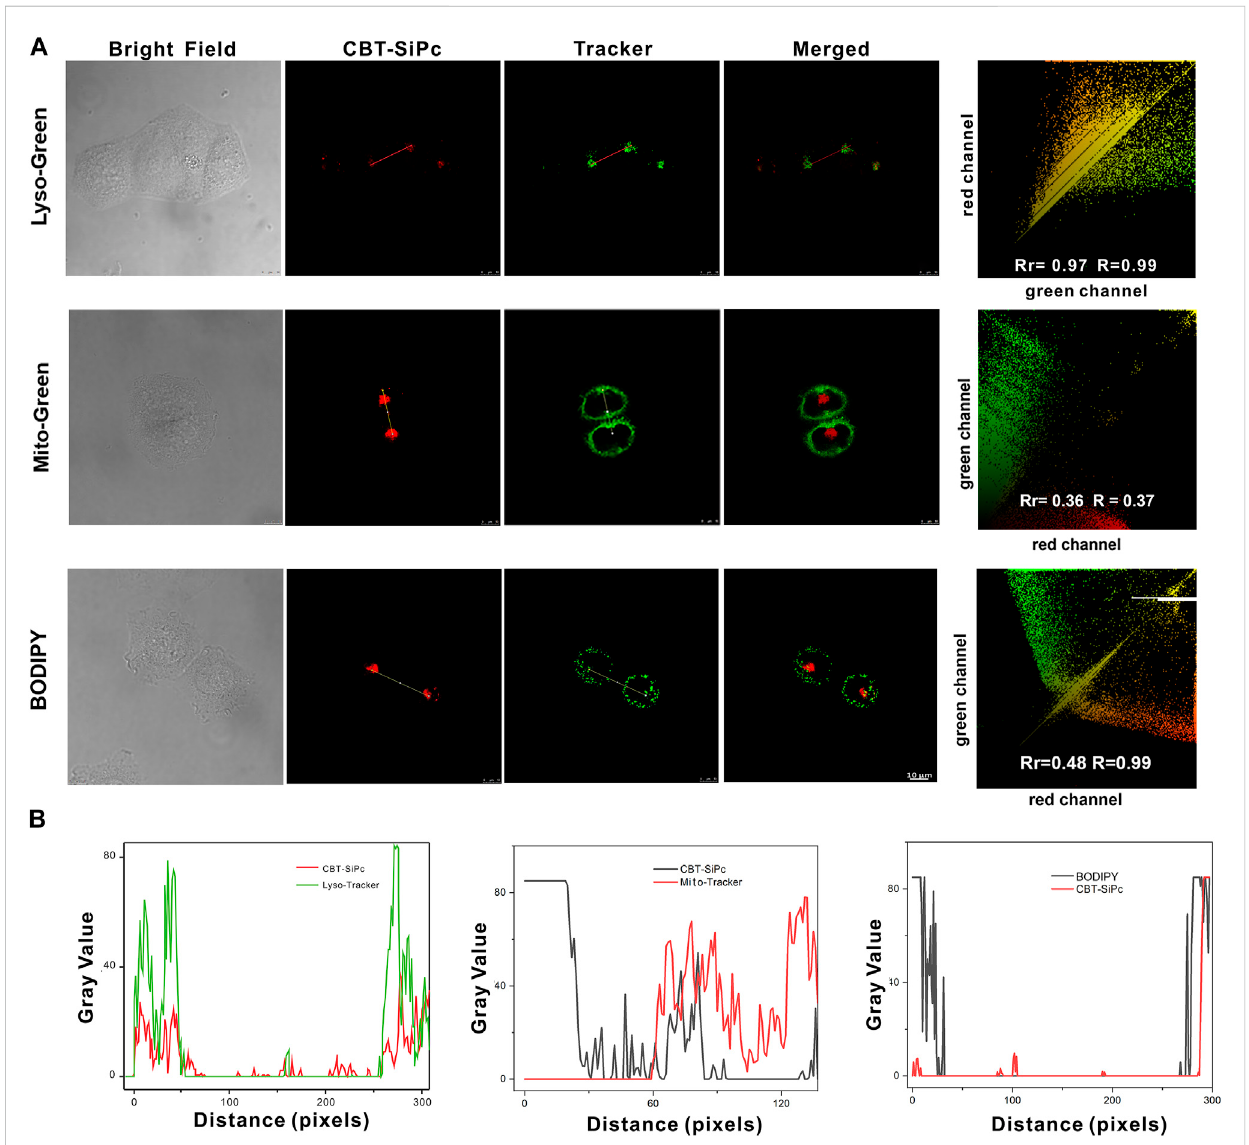
FIGURE 3 SubcellularlocalizationofCBT-SiPcinMCF-7breastcancercells. (A) IntracellulardistributionofCBT-SiPcinMCF-7cells.Lysosomes,mitochondria, and lipid droplets were stained with commercial LysoTracker (Lyso-Green), MitoTracker (Mito-Green), LipidTracker (BODIPY), and merged images observed by CLSM; (B) co-localization curves of CBT-SiPc with LysoTracker (Lyso-Green), MitoTracker (Mito-Green), and LipidTracker (BODIPY) (CBT- SiPc, excited by 860 nm fs laser). The fl uorescence was monitored at 650 – 750 nm. Lyso-Green was excited at 552 nm, and the fl uorescence was monitored at 580 – 620 nm. Mito-Green was excited at 488 nm, and the fl uorescence was monitored at 500 – 530 nm. BODIPY was excited at 488 nm, and the fl uorescence was monitored at 490 – 590